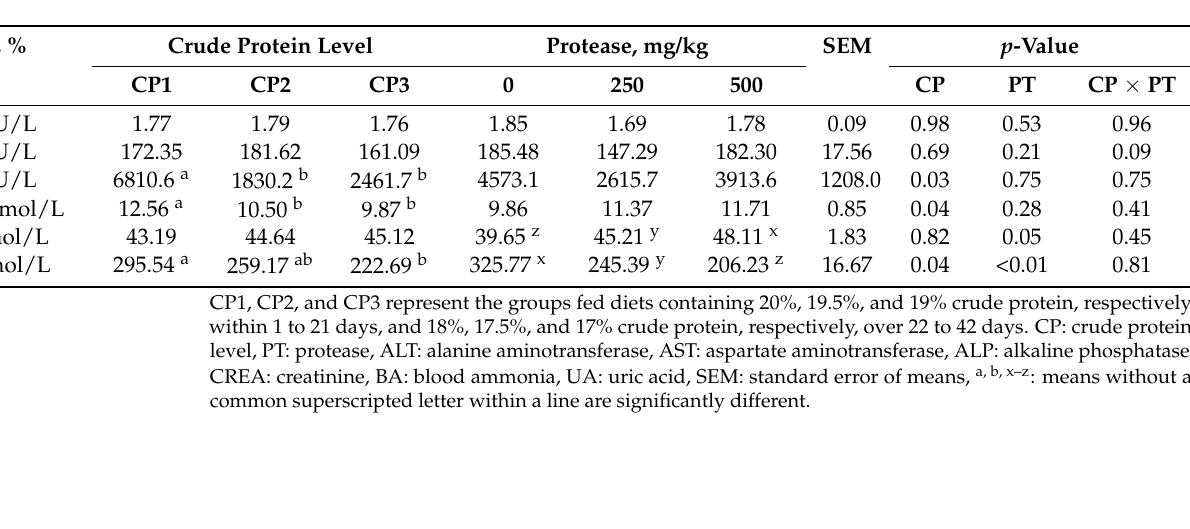
Table 5. Effects of dietary crude protein and protease levels on serum biochemical parameters of